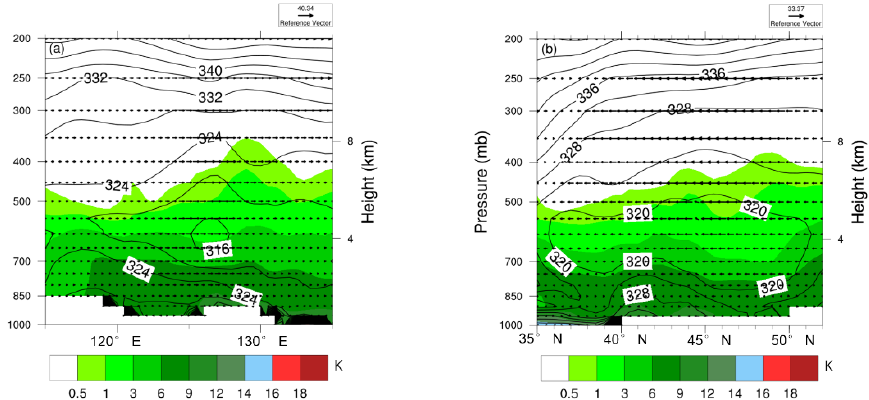
Figure 13. Vertical cross-section of pseudo-equivalent potential temperature (solid line; K) and specific humidity (shaded; g/kg) and uw (arrows; m · s − 1 ) along 42.5 ◦ N ( a ) and vw (arrows; m · s − 1